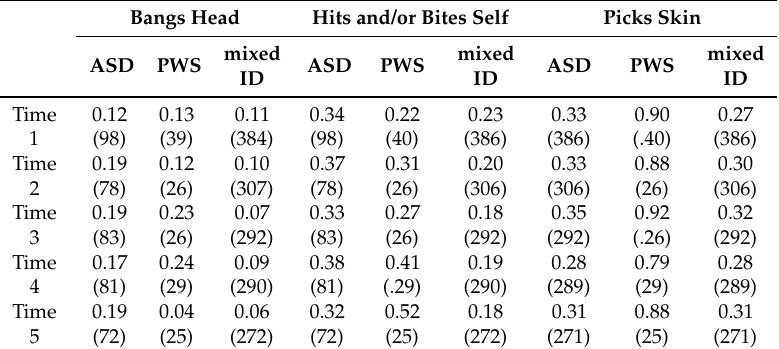
Table 1. Rates of behaviours over time.